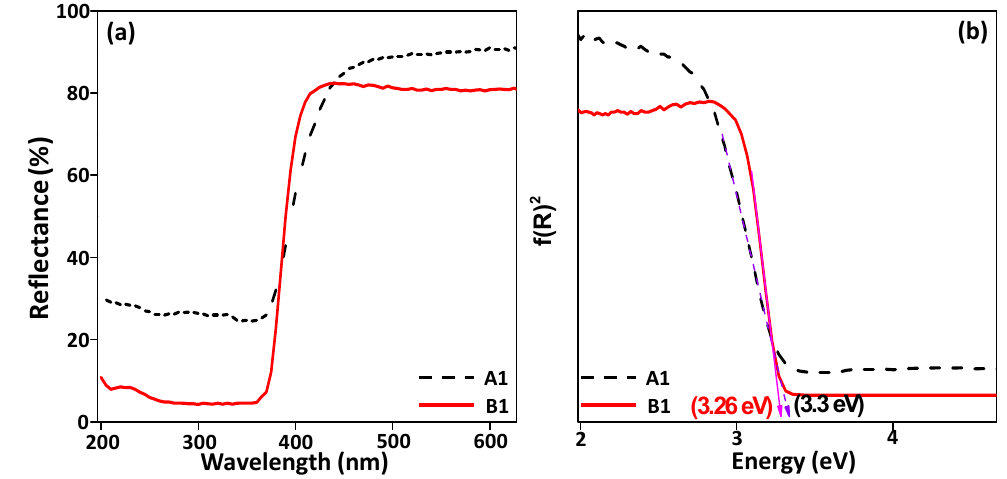
Figure 6. ( a ) UV-visible diffuse reflectance spectrum. ( b ) Bandgap calculation graph.